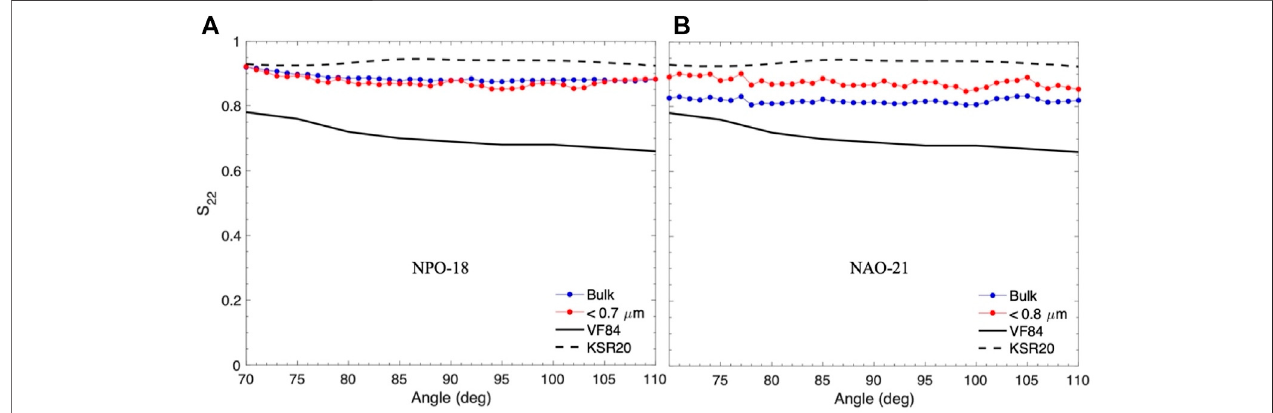
FIGURE6| Median values ofS 22 measuredfor thebulkand submicron particles inthe (A) NPO-18 and (B) NAO-21 sites. The black solidand dash lines aremean S 22 measured by Voss and Fry (1984) in the northern Paci fi c and eastern Atlantic oceans (VF84) and Koestner et al. (2020) in the coastal waters of San Diego (KSR20), respectively.